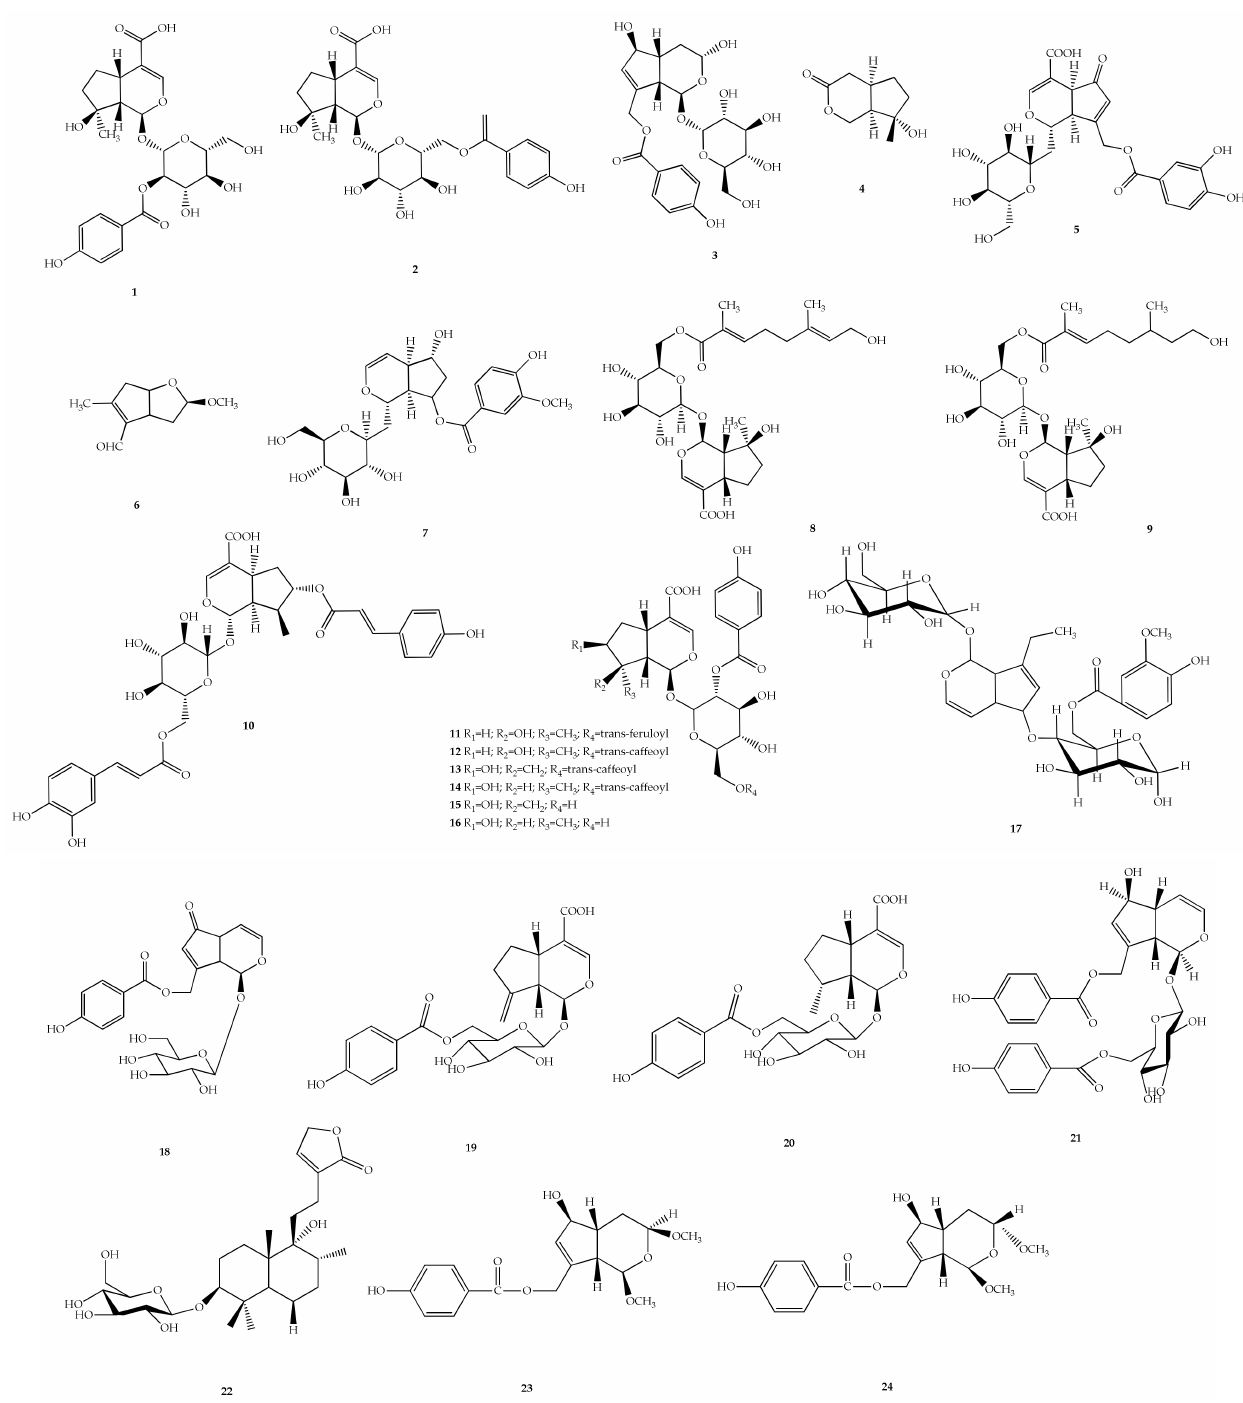
Figure 3. Chemical structures of iridoids 1 – 24 found in Vitex